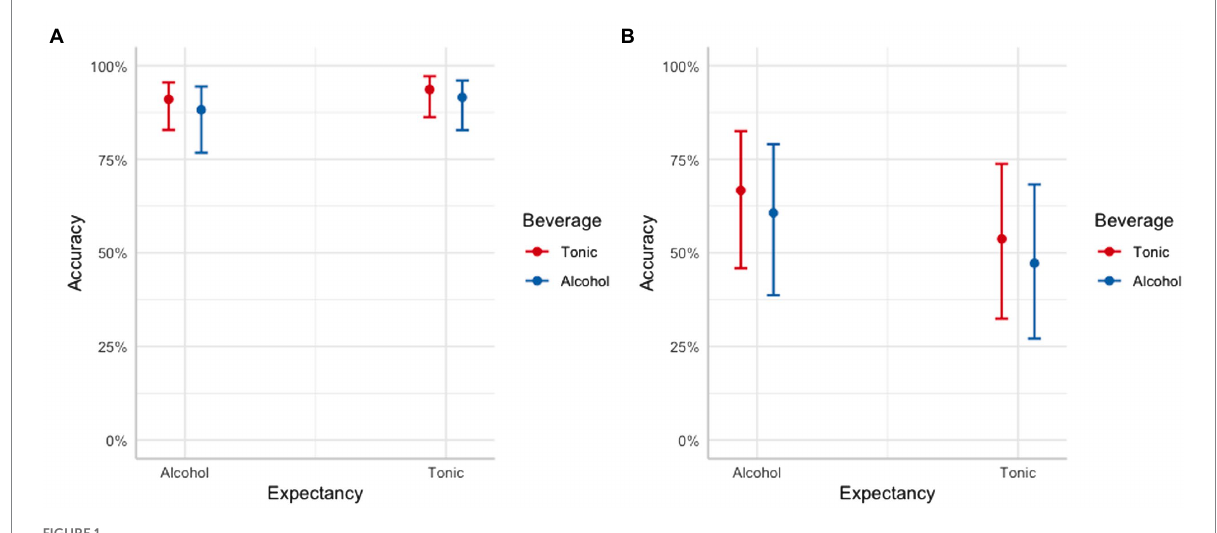
FIGURE 1 Mean accuracy (±1 SEM) as a function of beverage and expectancy condition for consensual sexual activity (A) and non-consensual sexual activity (B) .